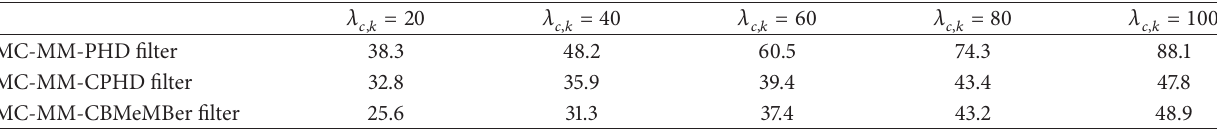
Table 2: Time-averaged OSPA distance ( 𝑚 ) in various 𝜆 𝑐,𝑘